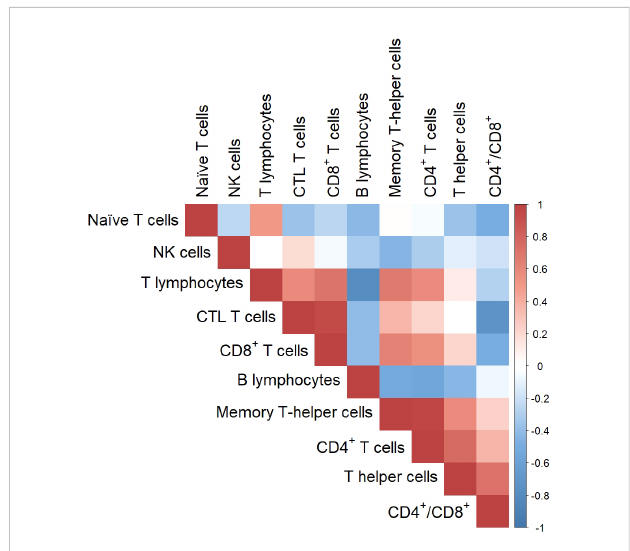
FIGURE 1 Heatmap of genetic correlations estimated by pairwise combination among cell immunity traits.